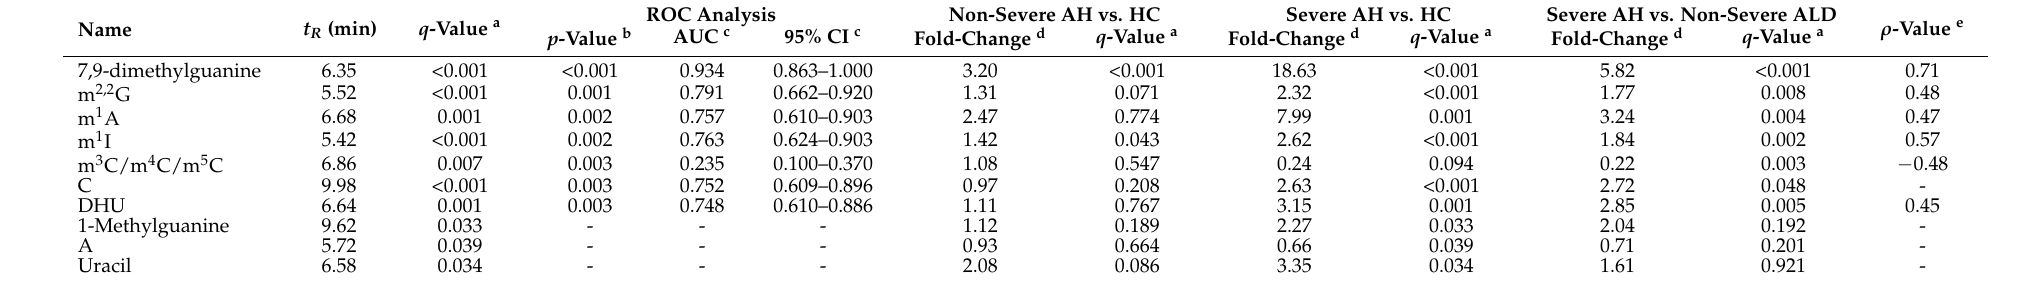
Table 2. Nucleosides/bases with significant abundance changes between groups in human